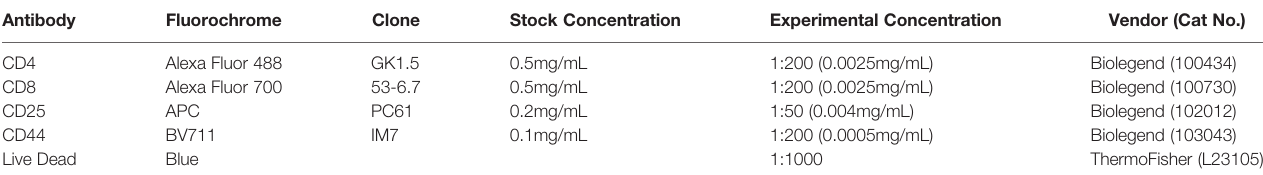
TABLE 2 | List of antibodies used for fl ow cytometry. Antibody Fluorochrome Clone Stock Concentration Experimental